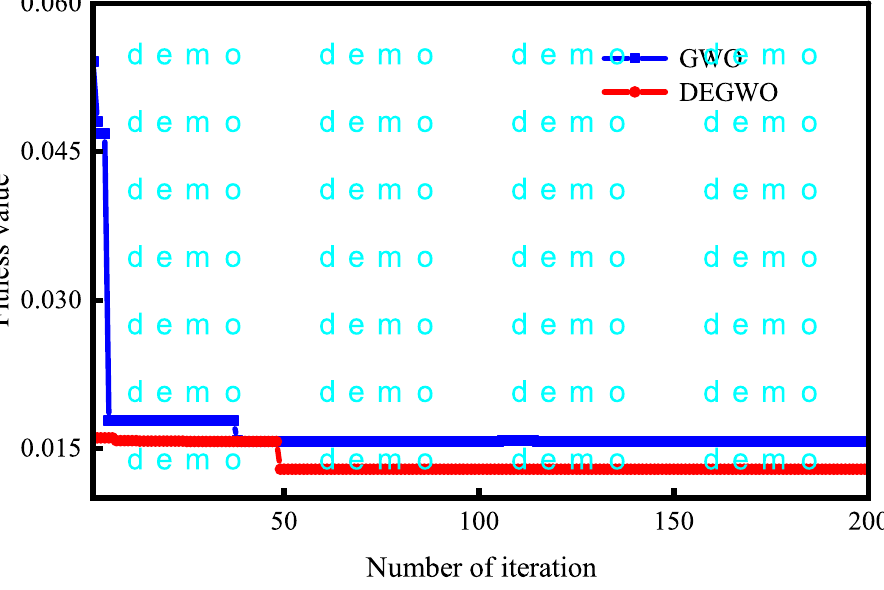
Fig 37. The fitness curves of the GWO and DEGWO model (conventional) of the